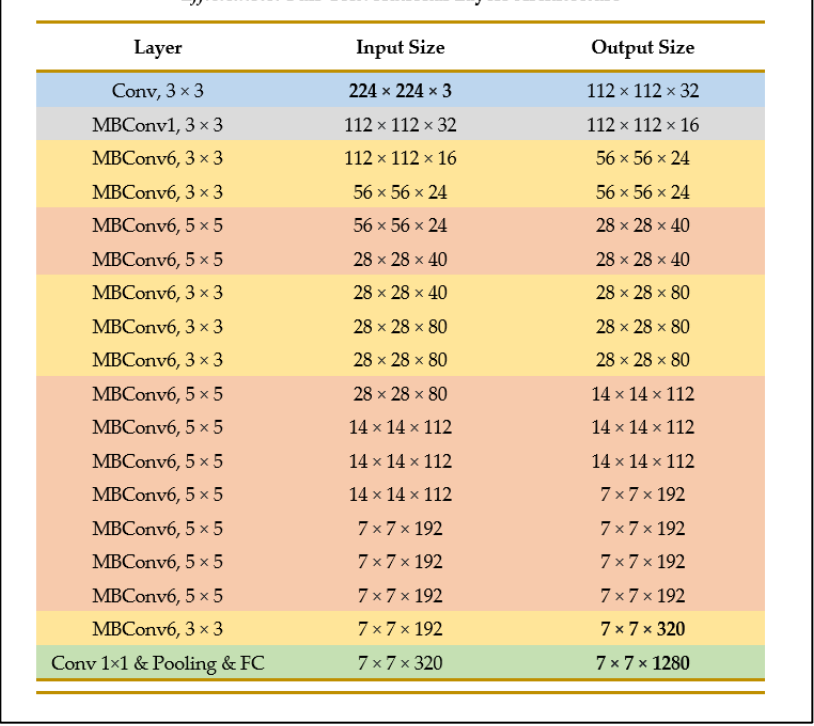
Figure 11. Breakdown of convolutional layers of EfficientNet (as outlined in [27]). The source dataset used to pre-train the EfficientNet-B0 model is the ImageNet dataset.